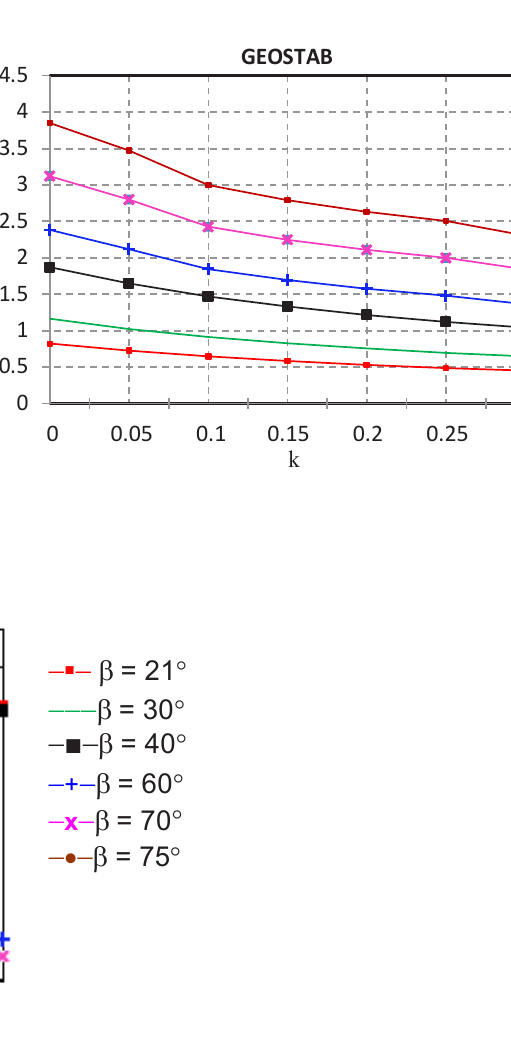
Figure 9: Effect of the slope